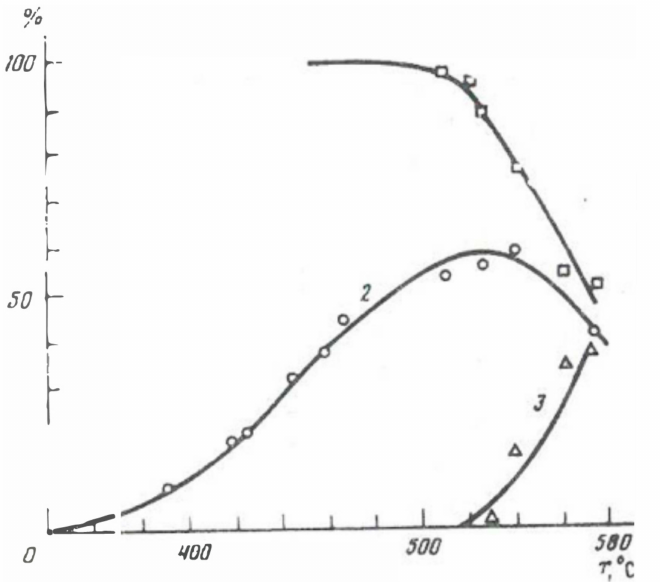
Figure 46. Catalytic performance of Sb 2 O 4 for MeOH oxidation as function of temperature. 1: Selectivity towards FA; 2: Yield of FA; 3: Yield of CO. Feed: 4.1 vol.% MeOH, 0.15 mL reaction mixture/(m 2 s)